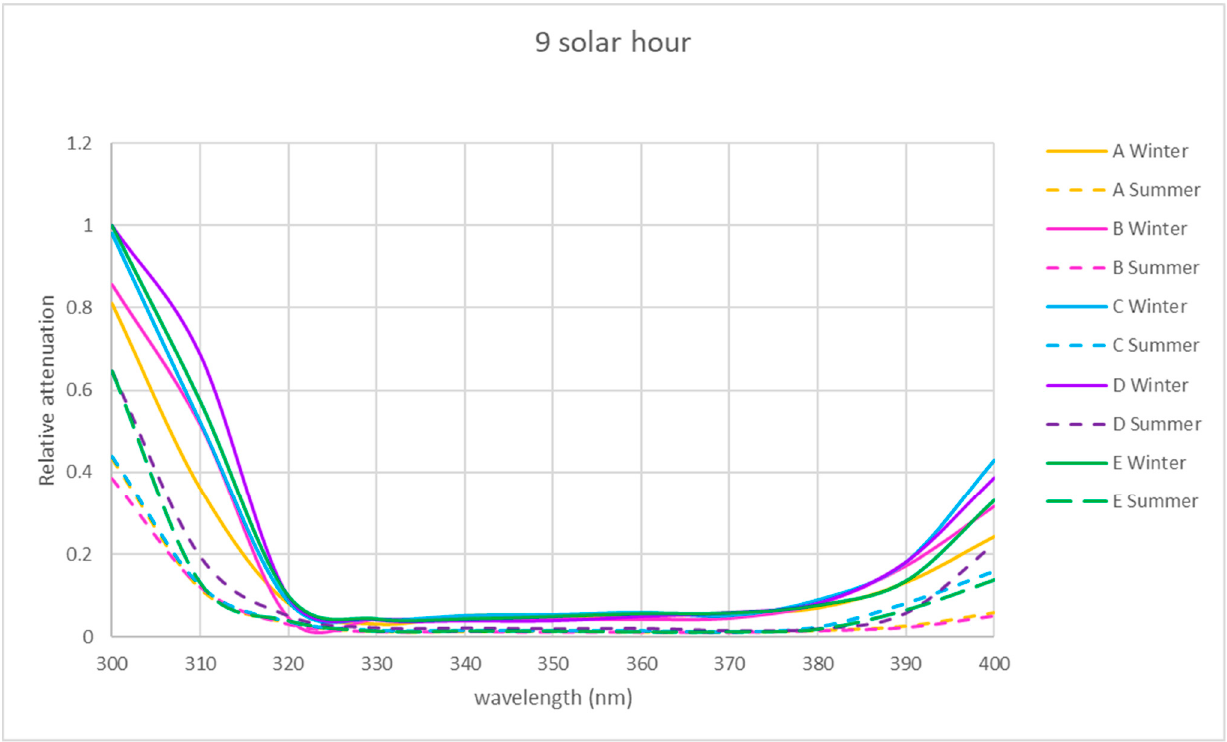
Figure 5. Representation of the spectral relative attenuation for the UV band for the 5 locations at 9 a.m. solar time. Figures 5–7 show that for the physical locations studied, the general trend is similar. The relative attenuation is at its maximum at 300 nm (80% on the walkway (A)) and almost 100% for locations within the ruins (C and D), and it decreases to 320 nm, where it is at its minimum, from 370 nm. The relative attenuation values then rise slightly again, reaching 40% for locations C and D and 25% for location